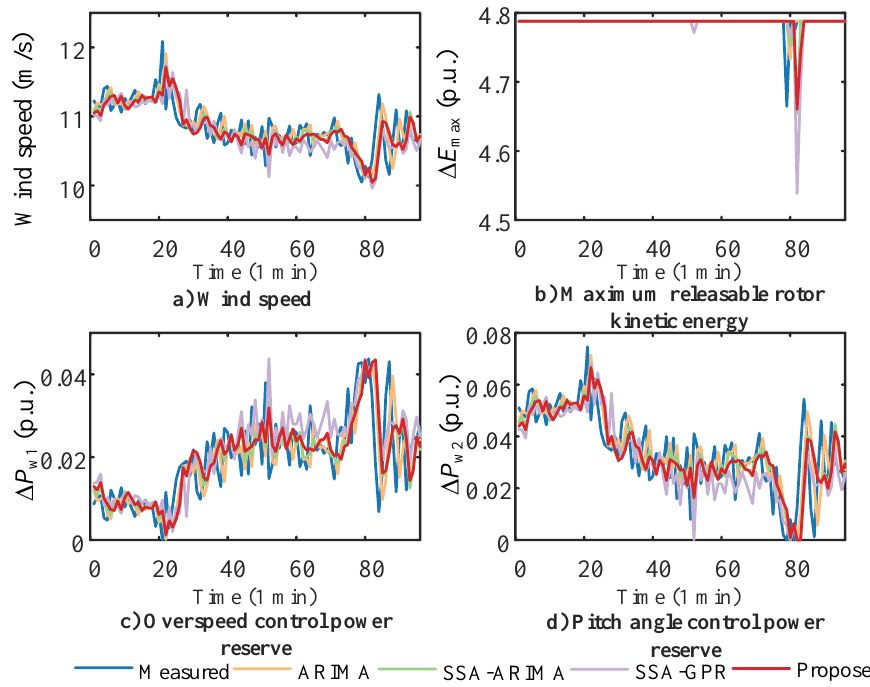
Figure 7. Deterministic prediction results.